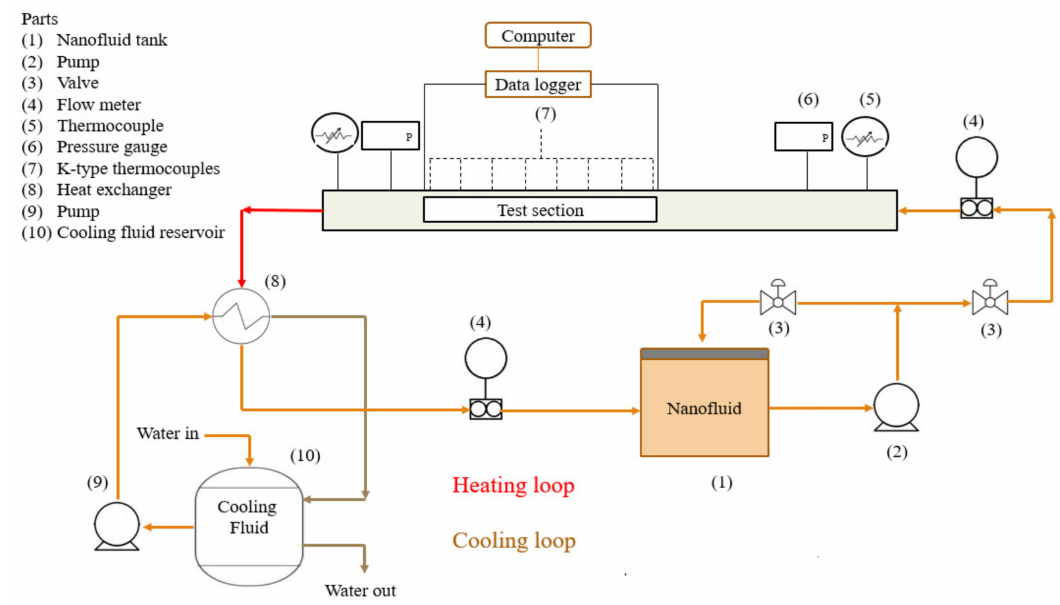
Figure 8. Schematic diagram of experimental